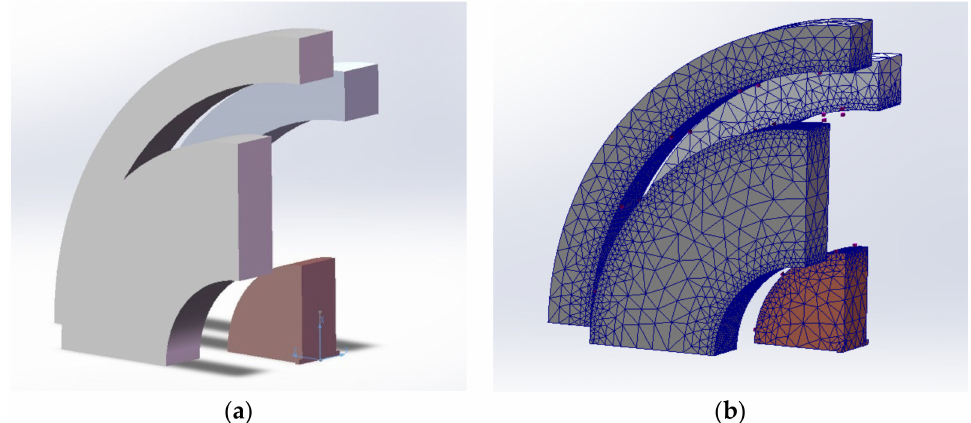
Figure 12. ( a ) SolidWorks modeling diagram (exploded view). ( b ) Model meshing.